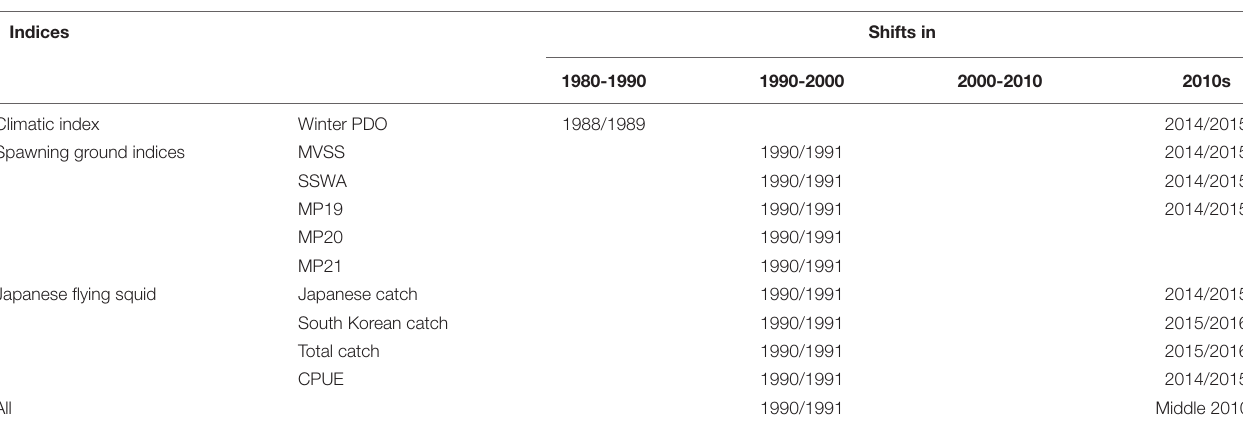
TABLE 4 | List of regime shifts detected by SRSD in various indices during 1979 to